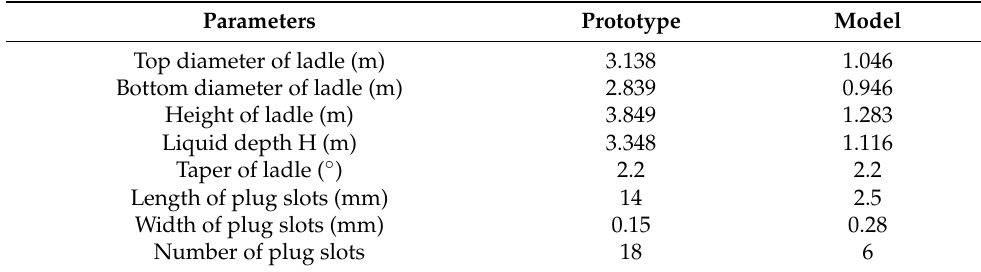
Table 1. Dimensional parameters of prototype and model.